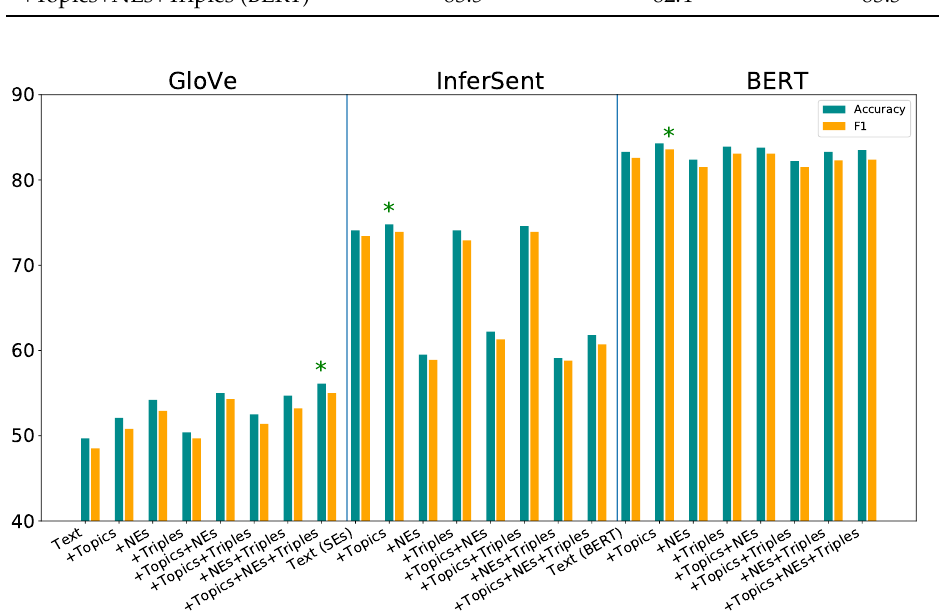
Figure 8. Performance results of classifiers from different inputs on the 20 News groups dataset. The first block of results uses GloVe-based representations. The second block is models using the InferSent sentence encoder. The third block uses BERT-based models. ∗ indicate the best model from each